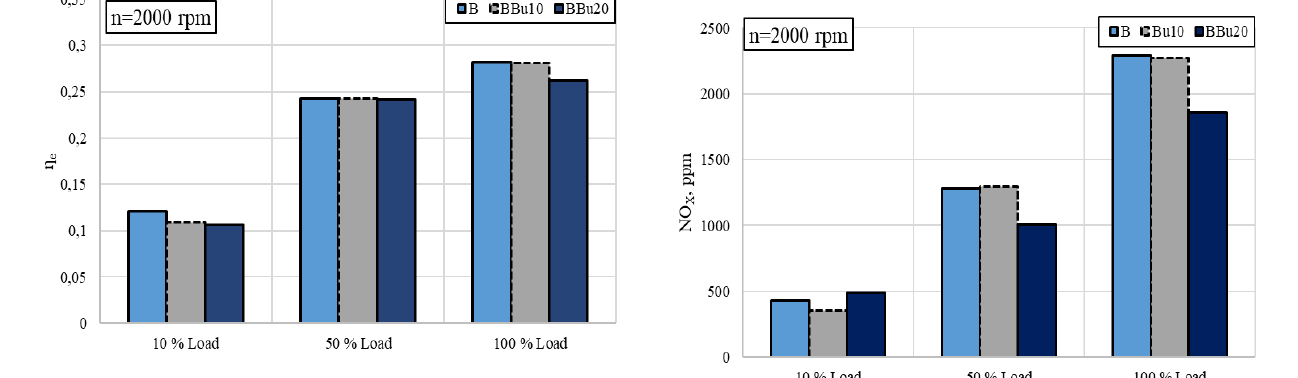
Fig. 3. The brake thermal efficiency as a function of engine load when running at maximum torque speed of 2000 rpm